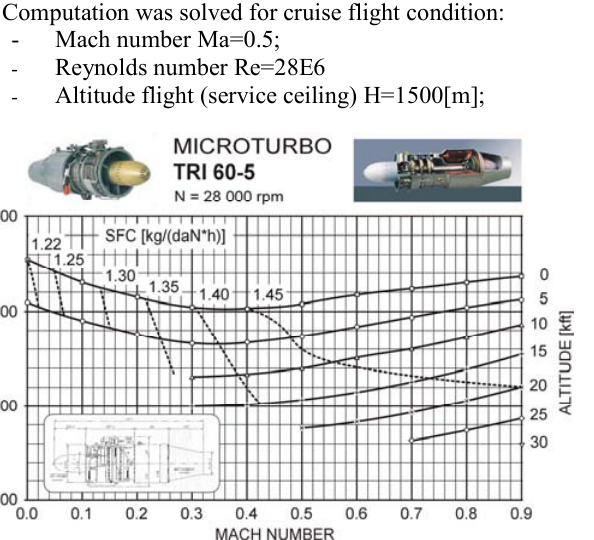
Fig 10. PW-124 – main systems layout